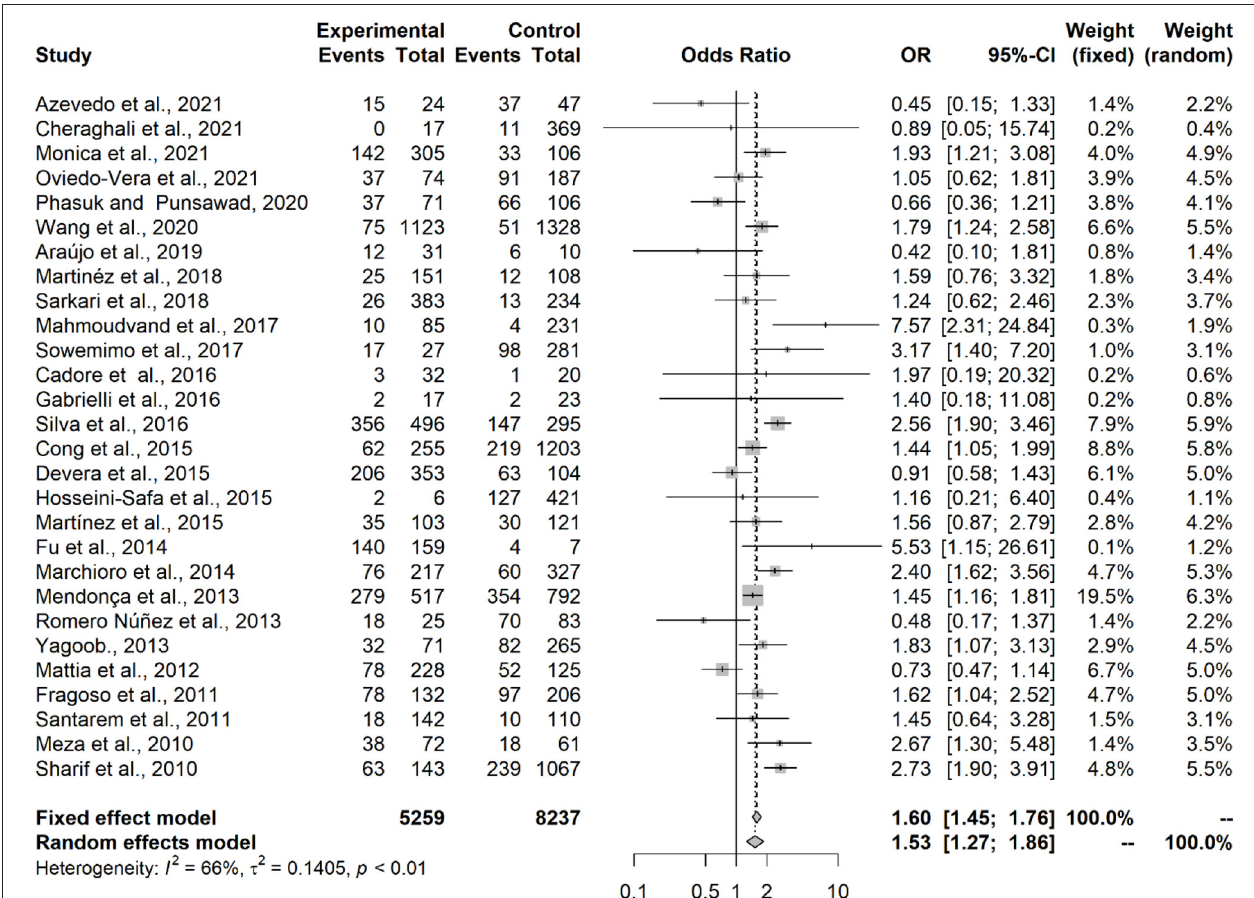
FIGURE 2 | Forest plot for assessment of odds-ratio of influence of contact with dogs in the frequency of anti- Toxocara antibodies in under-18 participants, according to selected articles used in the meta-analysis from 2009 to 2021.